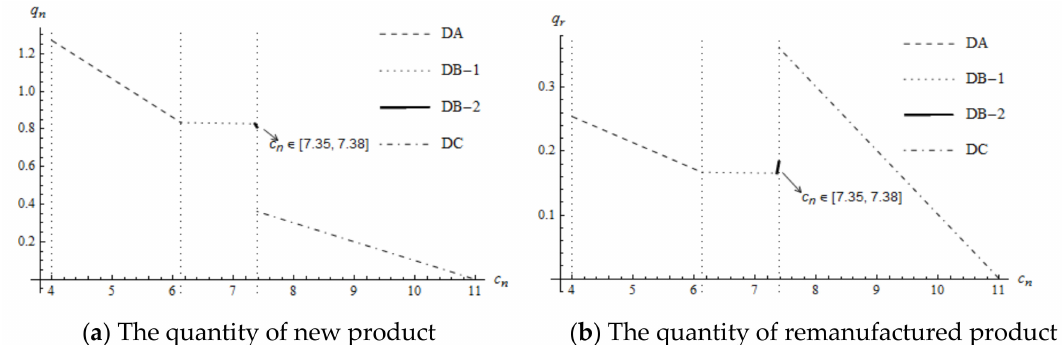
Figure 3. The impact of c n on the manufacturer’s production decision under low mandated remanufacturing